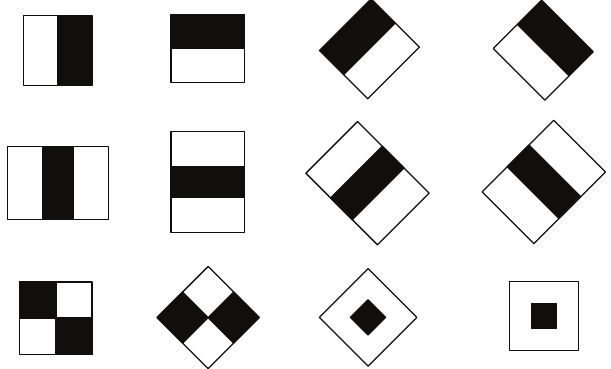
Figure 1: Simple haar-like features.